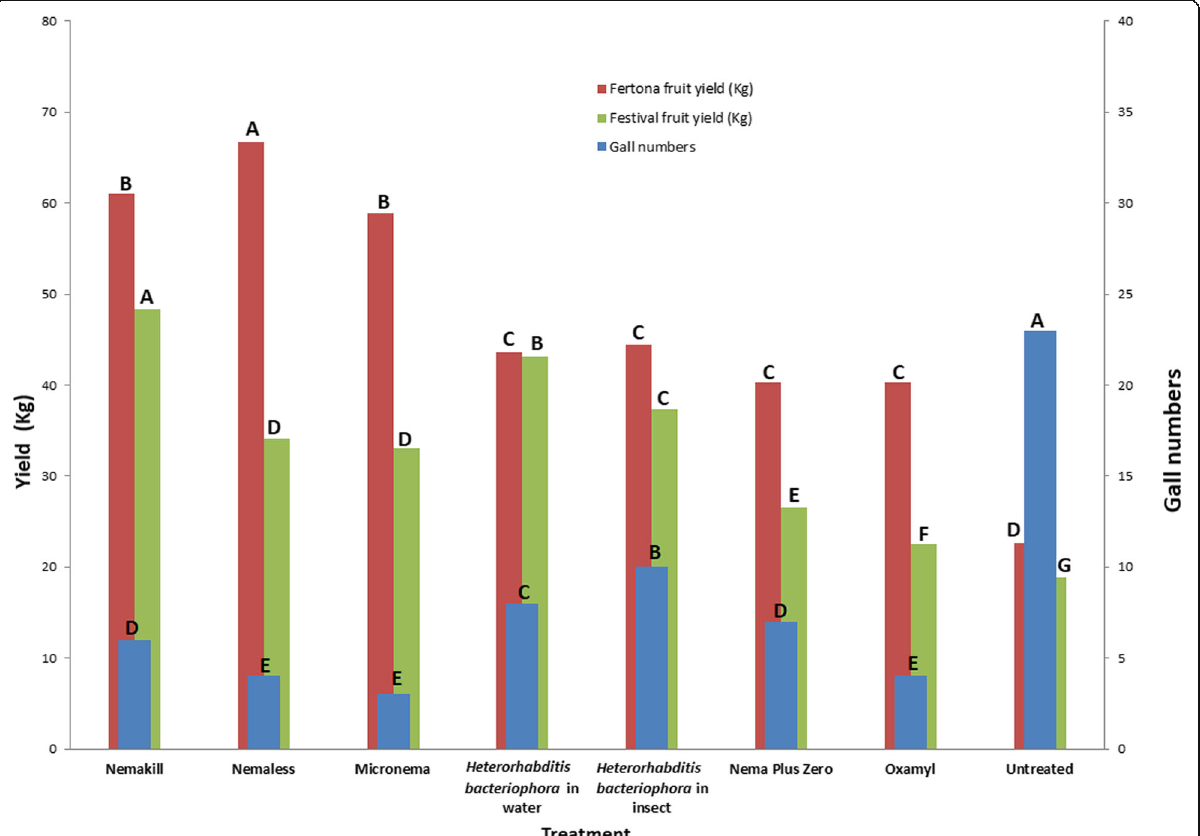
Fig. 3 Mean number of Meloidogyne incognita galls on two strawberry cultivars (Festival and Fortuna) treated with different nematicides to demonstrate their effects on the galls and fruit yield compared to untreated check. Means followed by the same letter on bars within a category did not differ significantly ( P ≤ 0.05) according to Duncan ’ s new multiple range test. Figure adapted from Tables 1, 3, and 4 in Hammam et al. (2019), based on data collected from two field experiments in